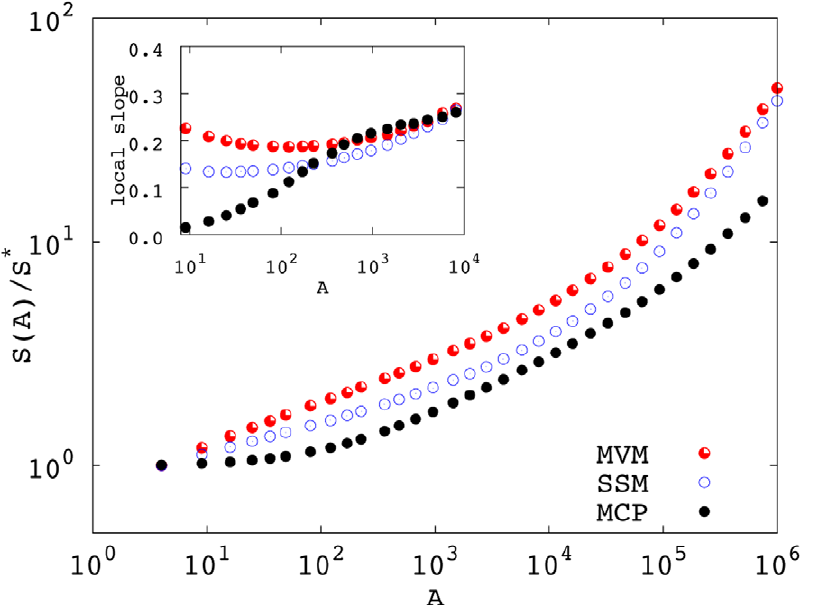
Figure 1. SARs generated by the three models at n ~ 10 - 6 ( n = m ~ 10 - 6 for the SSM) using nearest neighbor dispersal. The MVM and the SSM are simulated on a 1000 6 1000 square lattice. In the SSM, we chose M ~ 100 and m ~ 0 : 1 . The MCP is simulated on a 2500 6 2500 lattice with c ~ 1 : 68 adopting weighted averages (see Fig. 4 and related discussion). In all cases, we averaged over 5 | 10 2 { 10 3 independent realizations and statistical errors are smaller than symbols’ size. To ease the comparison, S has been normalized by the average number of species S (cid:2) at the smallest sampled area. Inset: local slopes d ln S = d ln A of the four curves for areas smaller than 10 4 .